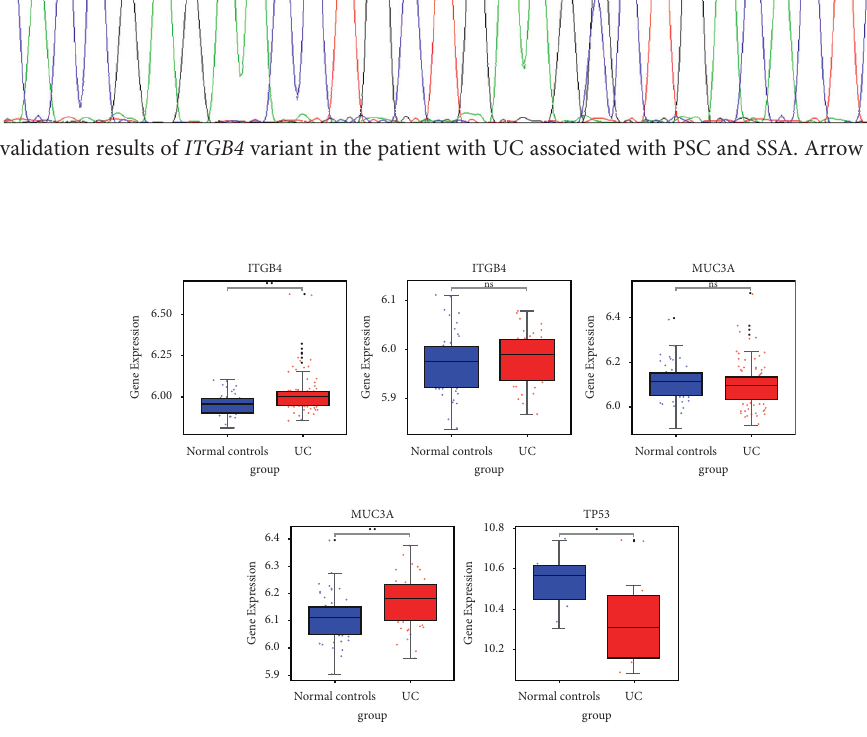
Figure 8: Expression box plots of ITGB4 , MUC3A , and TP53 in peripheral blood of UC and PSC and TP53 in tumor of SSA in the GSE43841 dataset.